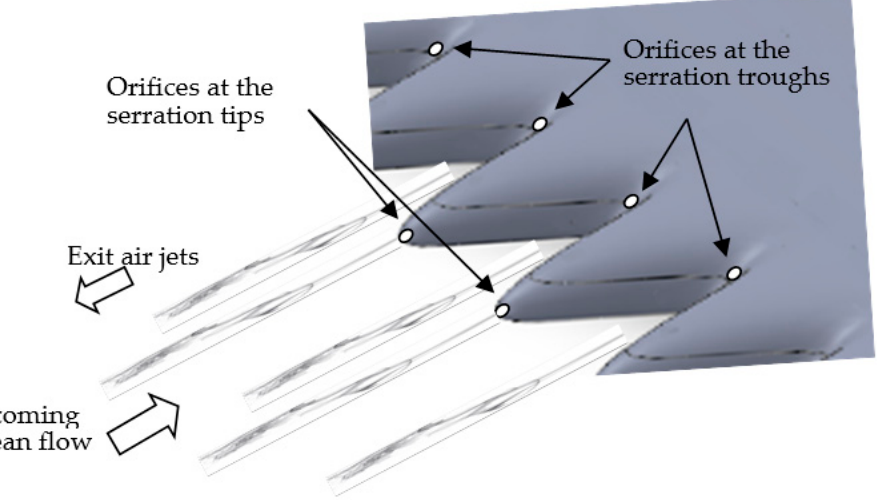
Figure 10. Isometric drawing of the hybrid device featuring a serrated leading edge with orifices at the serration troughs and tips for leading edge blowing. Note that the sketching of the exit air jets is not to scale, is for illustration only and may not represent the real flow behaviors.